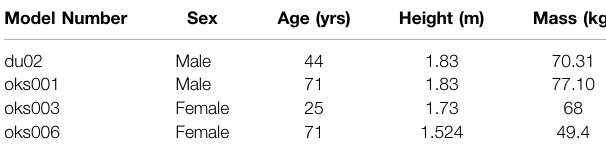
TABLE 1 | Subject data